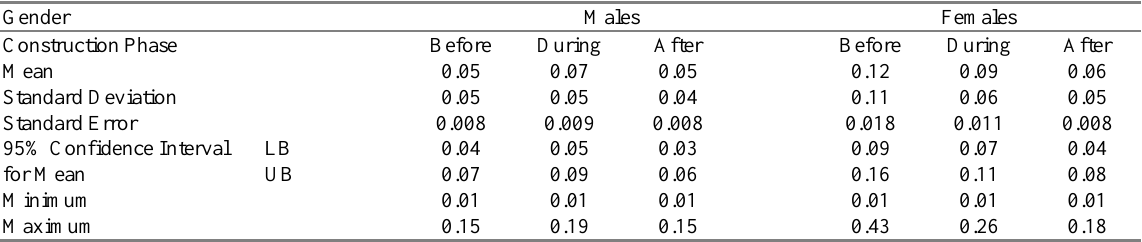
Descriptive Statistics of Sighting Probabilities of High Site Fidelity Bottlenose Dolphins across Three Phases of Construction, Adult Males n = 28, Adult Females n = 40 Gender Males Females